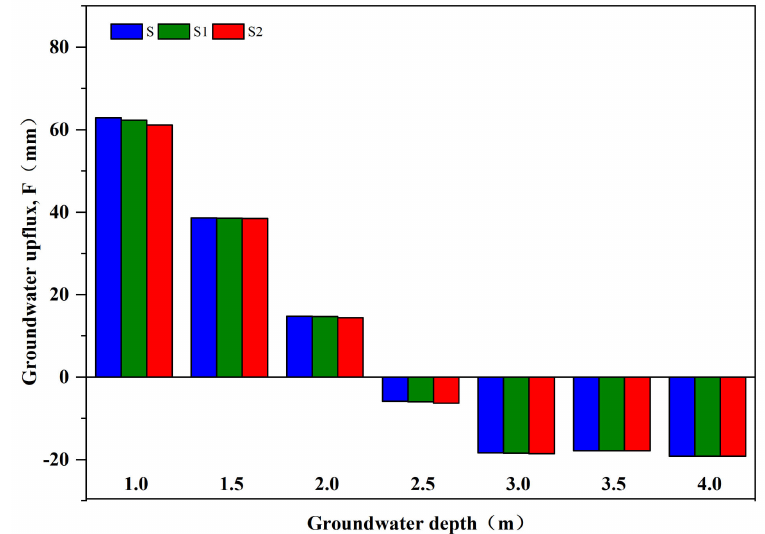
Figure 3. Water fluxes at water table during the growing period with groundwater depth ranging from 1 m to 4 m and groundwater salinity ranging from 1 to 4 g / L. Note: S, S1 and S2 refer to the scenarios with groundwater salinity of 1, 2 and 4 g / L,